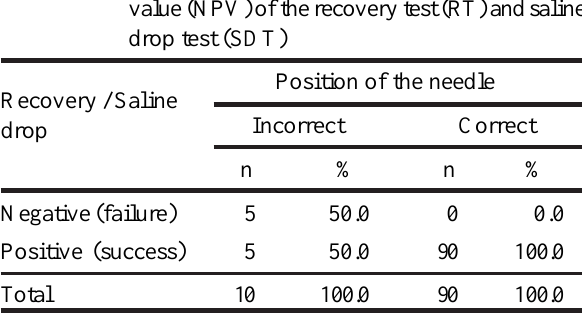
TABLE 6 - Calculation of sensitivity, specificity, positive TABLE 5 - Calculation of sensitivity, specificity, positive predictive value (PPV) and negative predictive predictive value (PPV) and negative predictive value (NPV) of the recovery test (RT) and saline